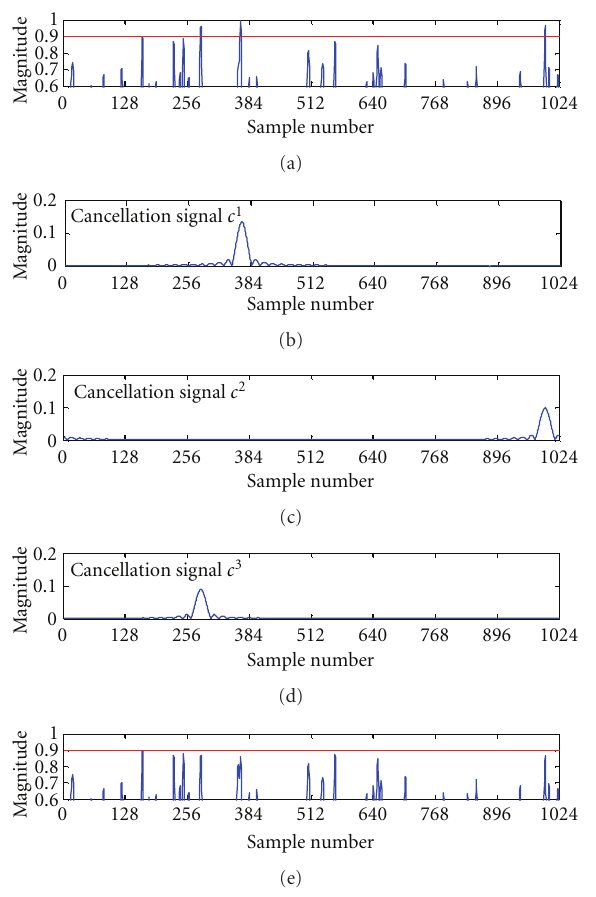
Figure 2: Multiple iterations cancellation process: (a) the original OFDM signal with threshold shown in solid line; (b) the cancel- lation signal generated during the 1st iteration; (c) the cancellation signal generated during the 2nd iteration; (d) the cancellation signal generated during the 3rd iteration; (e) the OFDM signal after PAPR reduction with 3 iterations.